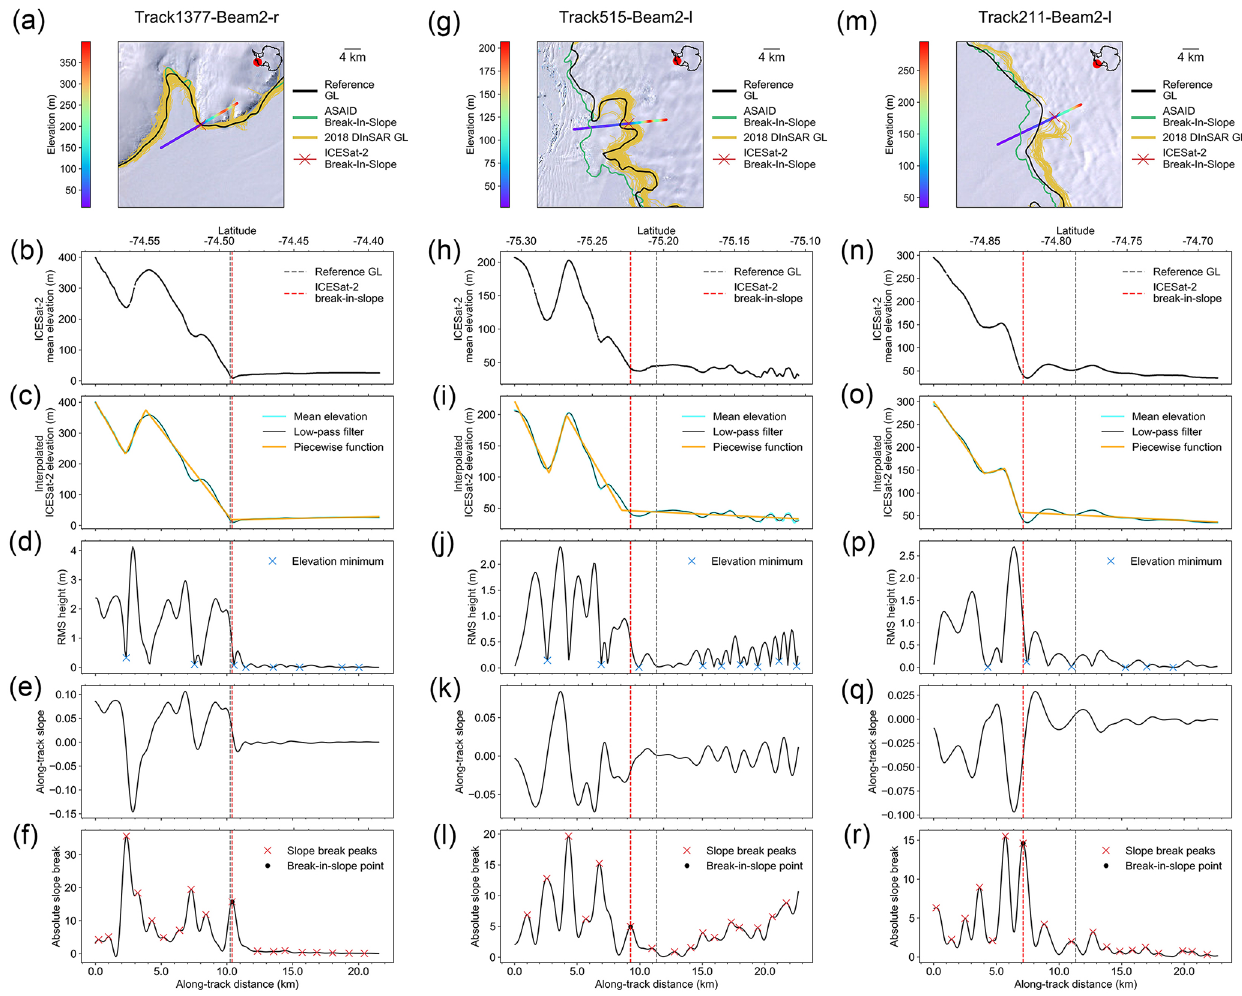
Figure 4. Estimation of break in slope (Point I b ) from ICESat-2 repeat tracks on the Amundsen Sea embayment. (a–f) Track 1377 on Bear Peninsula, (g–l) track 515 in the “butterfly” region of Thwaites Glacier, (m–r) track 211 on an unnamed glacier of Getz Ice Shelf. Geolocations and elevations of ICESat-2 elevation profiles for three different ground tracks are shown in (a) , (g) , and (m) superimposed on the Landsat Image Mosaic of Antarctica (Bindschadler et al., 2008); the reference grounding line (GL) is shown as a black line, the ASAID break in slope is shown as the green line (Bindschadler et al., 2011); the Sentinel-1a/b DInSAR-derived GL is shown as the yellow line (Mohajerani et al., 2021); the ICESat-2-derived break in slope is shown as a red cross. (b, h, n) The reference elevation profile along the nominal reference track. (c, i, o) The interpolated reference elevation profile is shown as the solid cyan line; the low-pass-filtered interpolated reference elevation profile is shown as the solid black line; the four-segment piecewise function fitting is shown as the solid yellow line. (d, j, p) The along-track rms height of the reference elevation profile; local elevation minima are shown as the blue crosses. (e, k, q) The along-track slope of the reference elevation profile. (f, l, r) The absolute slope break along the reference elevation profile; peaks of the slope break are shown as red crosses, and the final break in slope Point I b is shown as the black dot. Locations of Point I b and the reference GL are marked as the vertical dashed red line and the vertical dashed black line in all panels apart from (a) , (g) , and (m) .